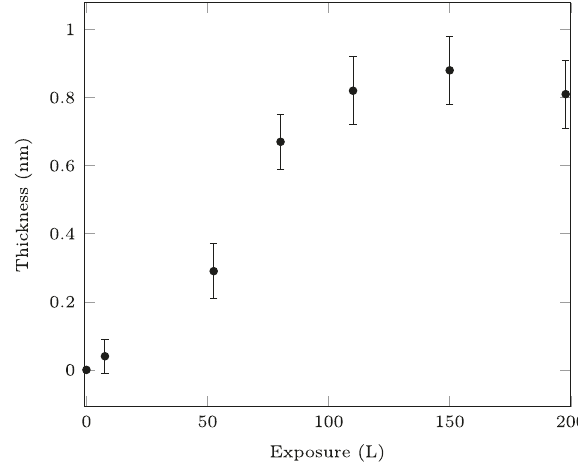
Fig. 8 Thickness of the 2-MBI fi lm formed on the metallic Cu(111) surface. The error bars were estimated by taking into account the errors of all the parameters used for